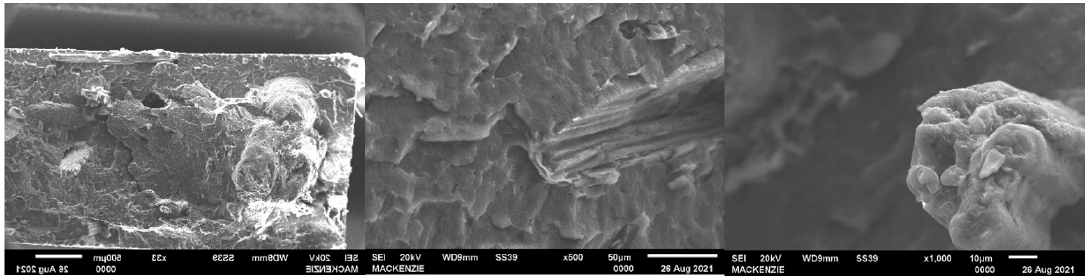
Figure 10. SEM image of PP with 25wt% fiber (33, 500, and 1000 times